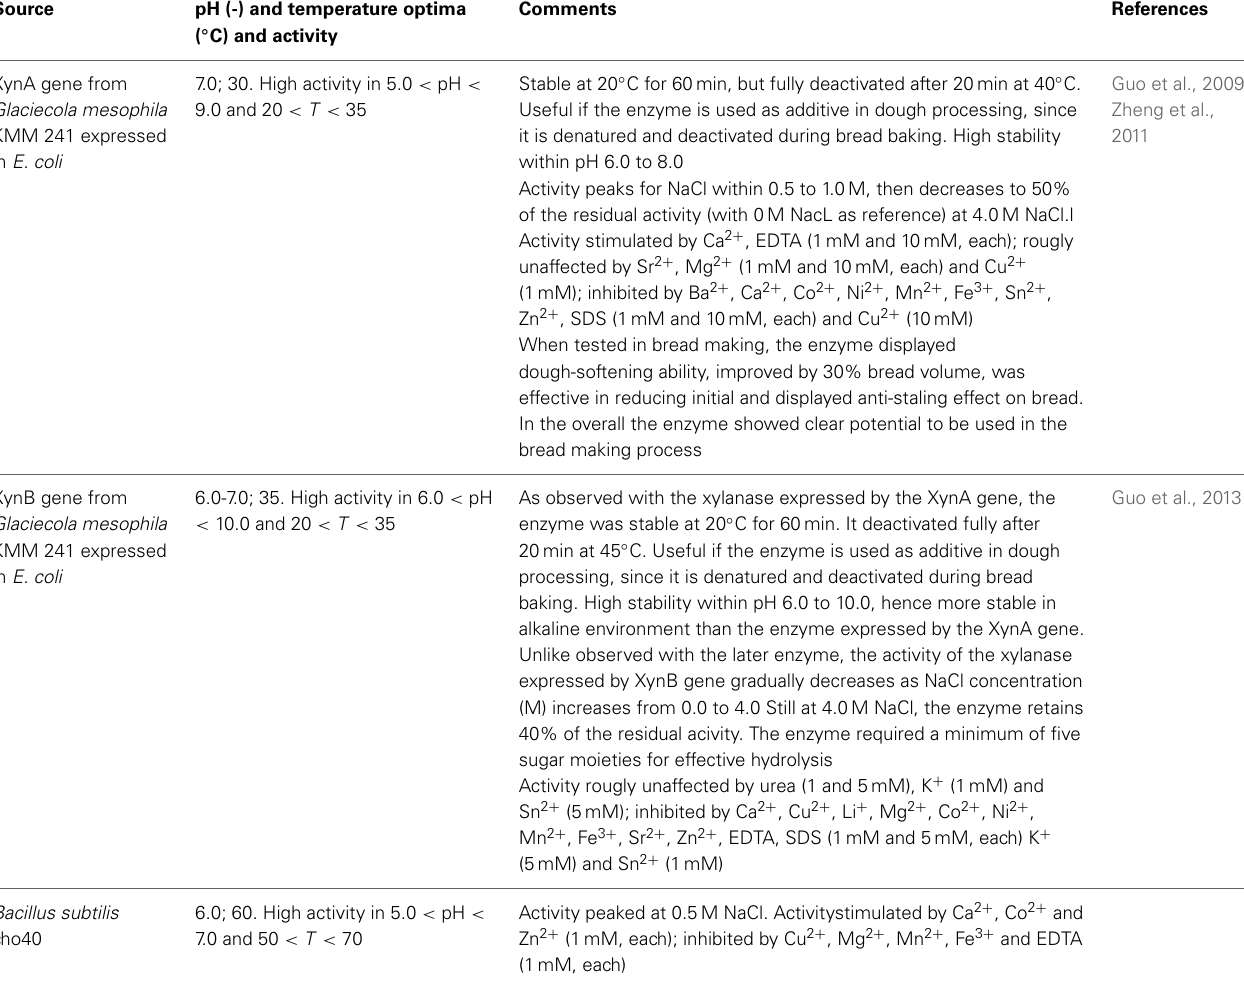
Table 10 | Xylanases from marine